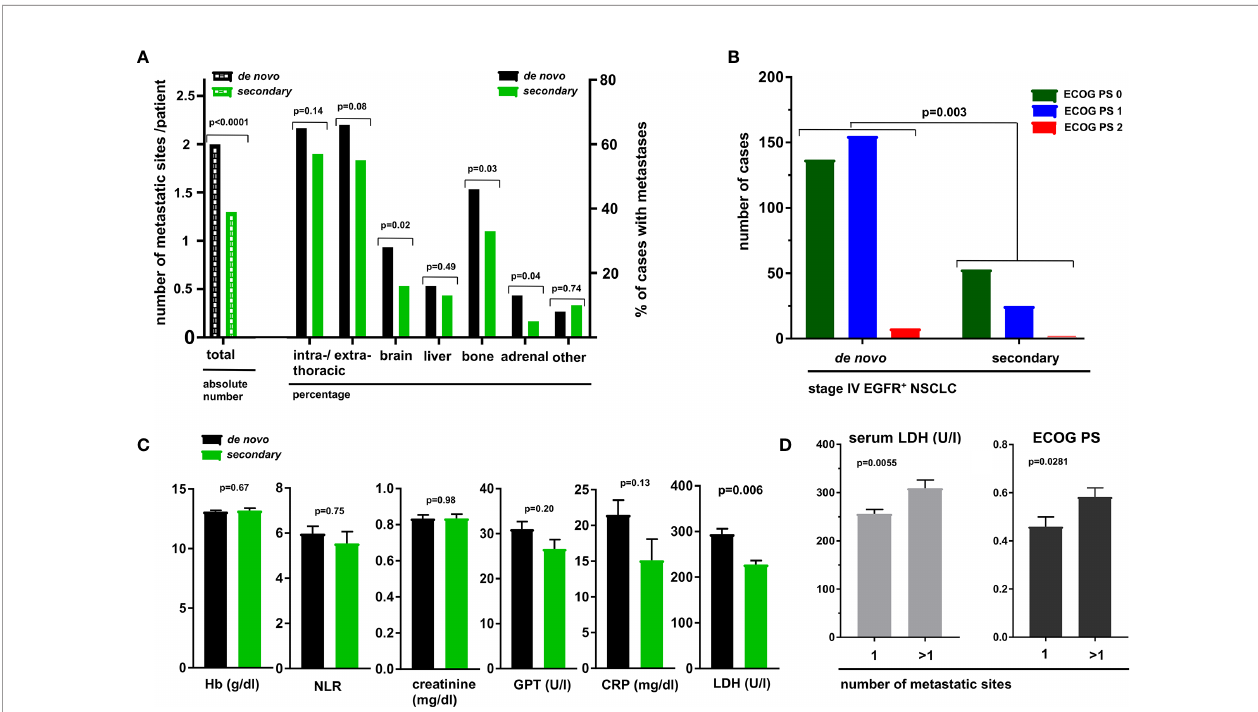
FIGURE 1 | Metastatic spread, ECOG performance status (PS), and basic laboratory values at diagnosis of de novo vs. secondary metastatic EGFR + NSCLC. (A) The average number of metastatic sites (lung, pleura, brain, liver, bone, adrenals, other) and the percentage of cases with metastases for each localization in de novo vs. metastatic stage IV EGFR + NSCLC. Statistical comparisons were performed with the Student ’ s t-test for numerical (left part), and with the chi-square test for categorical data (right part). Details are shown in Supplementary Table 1 . (B) The distribution of ECOG PS among patients diagnosed with de novo vs. secondary stage IV EGFR + NSCLC, compared with a chi-square test. Details are shown in Table 1 . (C) Results of basic laboratory tests at diagnosis of de novo vs. secondary stage IV EGFR + NSCLC, compared with the Student ’ s t-test. Boxes and error bars show mean values and standard errors. Details are given in Supplementary Table 2 . (D) Relationship between serum LDH and the number of metastatic sites at diagnosis of stage IV EGFR + NSCLC (p = 0.006 with the Student ’ s t-test). Boxes and error bars show mean values and standard errors. Details are given in Supplementary Table 2 . Relationship between the ECOG PS and the number of metastatic sites at diagnosis of stage IV EGFR + NSCLC (p = 0.028 with the Student ’ s t-test). Boxes and error bars show mean values and standard errors, respectively. Details are given in Table 1